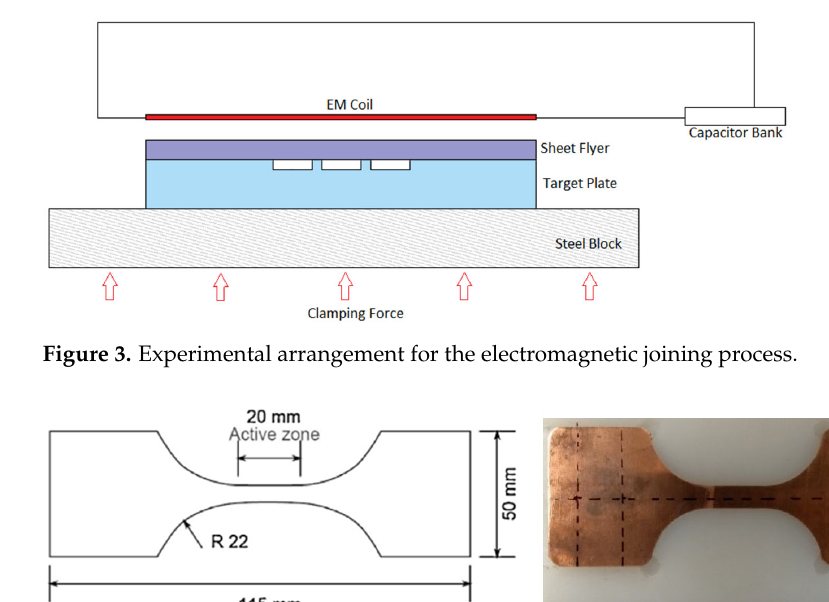
Figure 2. Materials prepared for the multi ‐ spot EMJ (dimensions in mm).